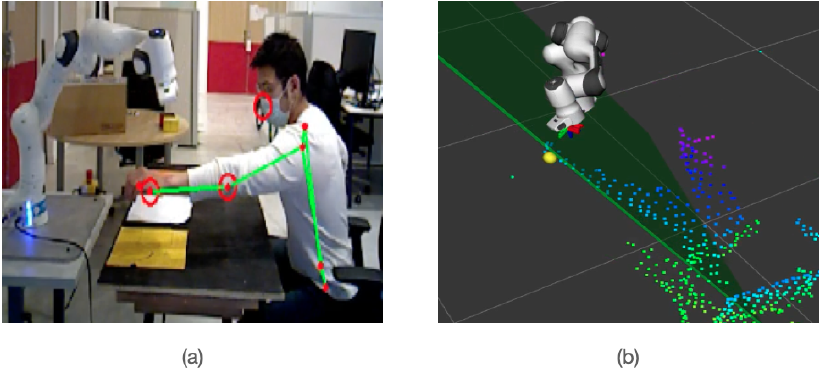
Figure 10. A case study on which collision can not be avoided, ( a ) human blocks cobot motion intentionally, ( b ) the trajectory generator ensures that the cobot is at rest to avoid